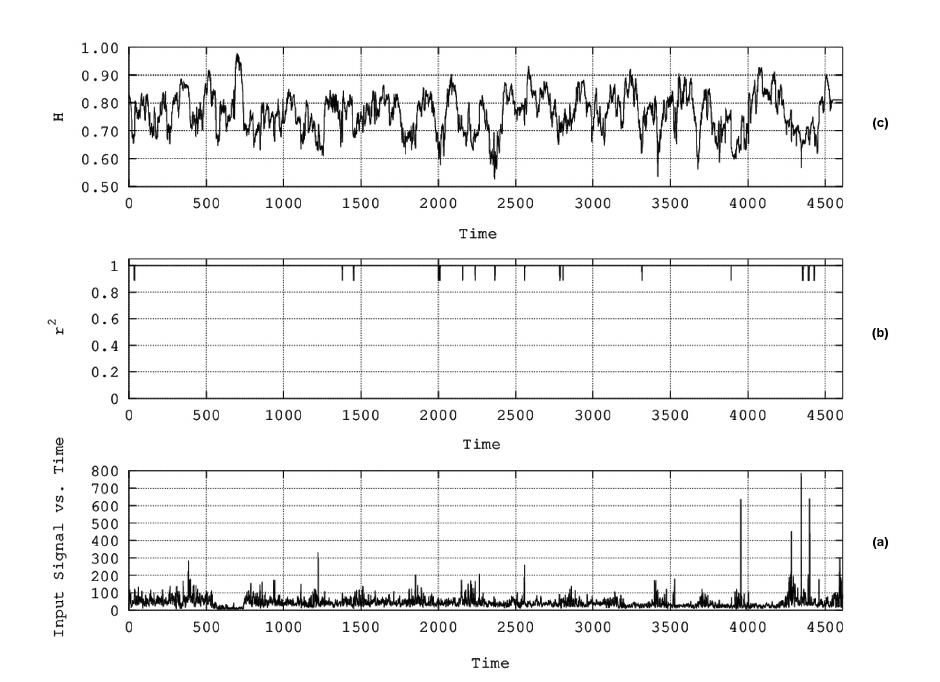
Figure 7. R/S analysis of the PM 10 time series recorded by the MAR station between the years 2001–2016. From bottom to top: ( a ) time series (mean daily values/concentrations). ( b ) Square of Spearman’s correlation coefficient. ( c ) Hurst exponent time series. PM 10 concentration in µ g/m 3 . Time is in days (or sample number). Each window of analysis contains 64